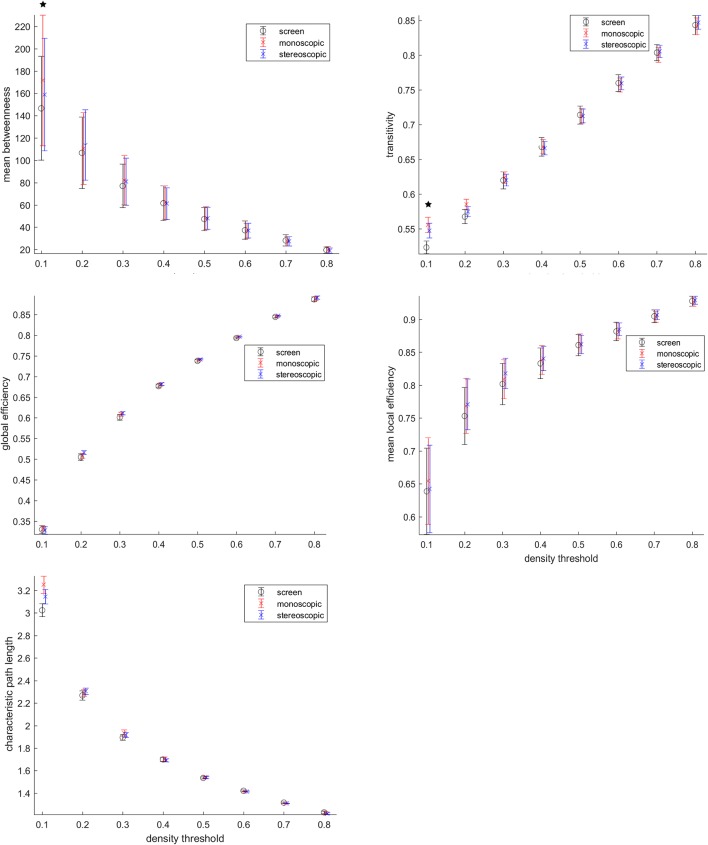
Graph analysis. Betweenneess, transitivity, global efficiency, local efficiency and characteristic path length were calculated. *Means group differences before multiple comparison correction (p < 0.05 uncorrected). Group differences were not significant after multiple comparison correction.